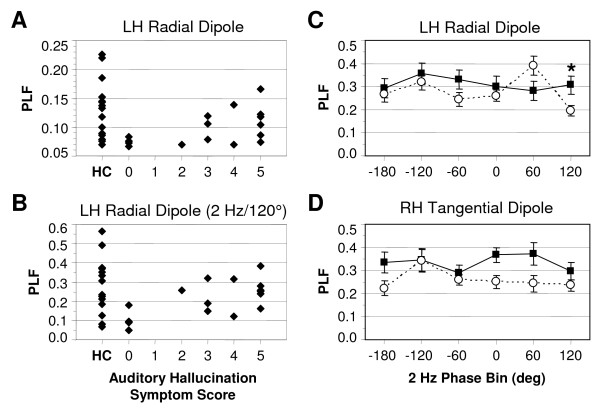
Auditory hallucination correlations and cross-frequency interaction data. (A and B) Scatterplots of LH radial dipole PLF vs. Auditory Hallucination symptom ratings. The HC values are displayed for comparison with the range of SZ values. (A) LH radial dipole PLF over all trials (ρ = 0.541, p < 0.05). (B) LH radial dipole PLF in the 120–180° phase bin for 2 Hz modulation (ρ = 0.617, p < 0.01). (C and D) ASSR PLF plotted as a function of 2 Hz phase for the LH radial (C) and RH tangential (D) dipoles. HC = filled squares, SZ = open circles. In (C), the asterisk indicates the significant reduction of LH radial dipole PLF in SZ for the 120–180° phase bin.